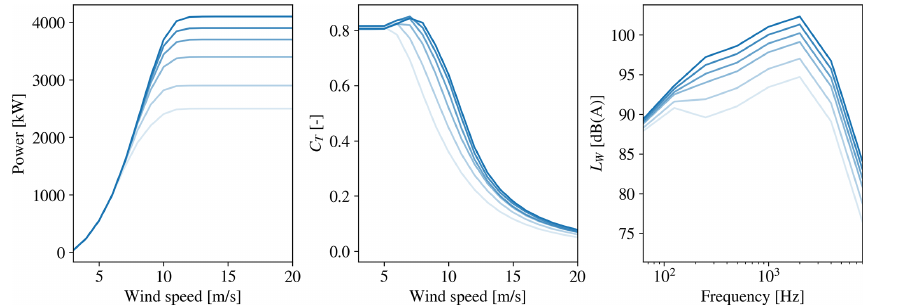
Figure 3. SWT-DD-142: the power, C T and L W curves for each operational mode at U hub = 10ms − 1 . From dark to light blue is the least noise reducing mode, m = 0, to the most noise reducing mode, m =